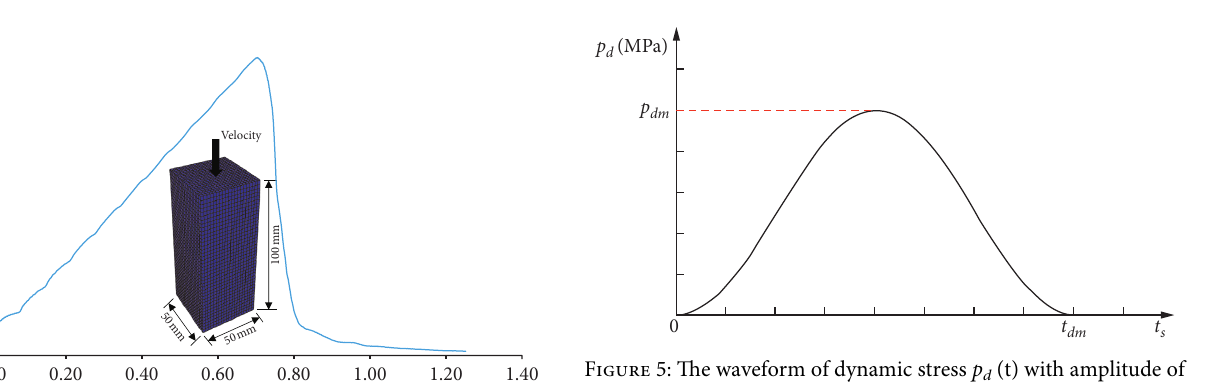
d (t) with amplitude of